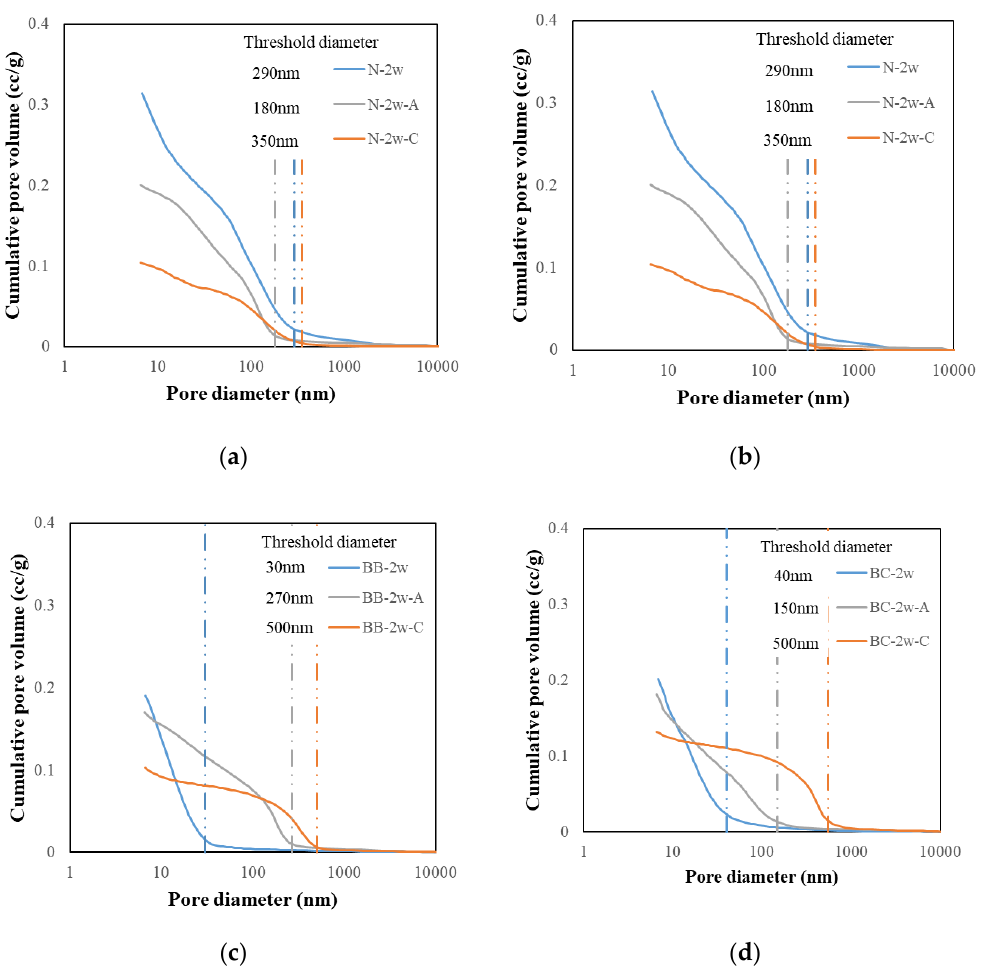
Figure 8. Cumulative pore volume and threshold diameter of carbonated cement paste. ( a ) N; ( b ) BA; ( c ) BB and ( d ) BC.